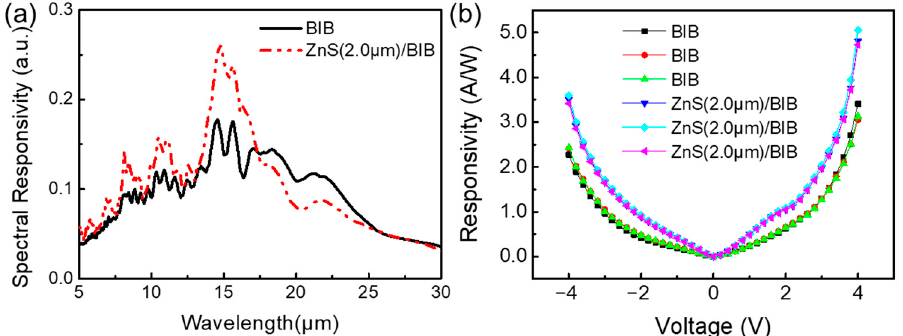
Figure 4. ( a ) Spectral responsivities of the Si-based BIB detector with and without ZnS coating. ( b ) Blackbody responsivity curves for three pixels of Si-based BIB detector with and without ZnS coating.